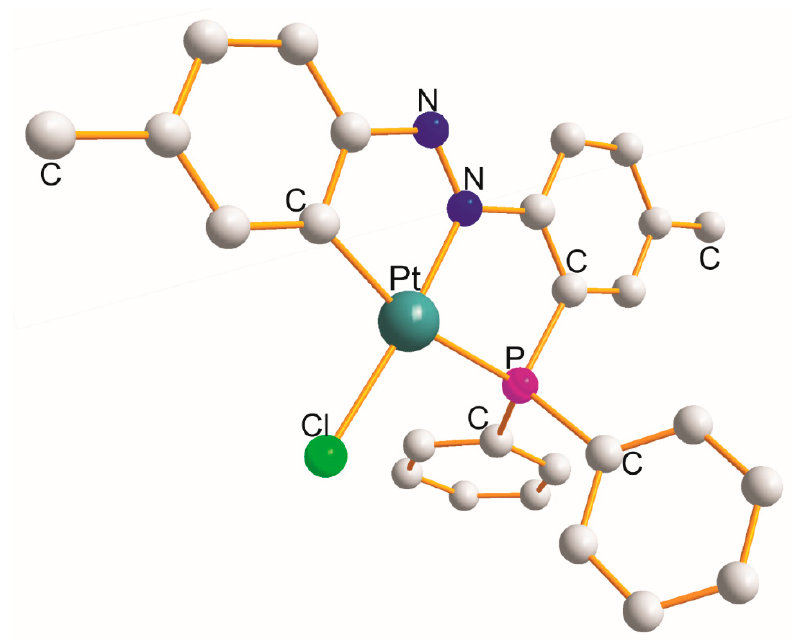
Figure 2. Structure of [Pt{ κ 3 –Ph 2 P 1 (C 7 H 6 N 1 = NCC 1 C 5 H 6 )}(Cl)]